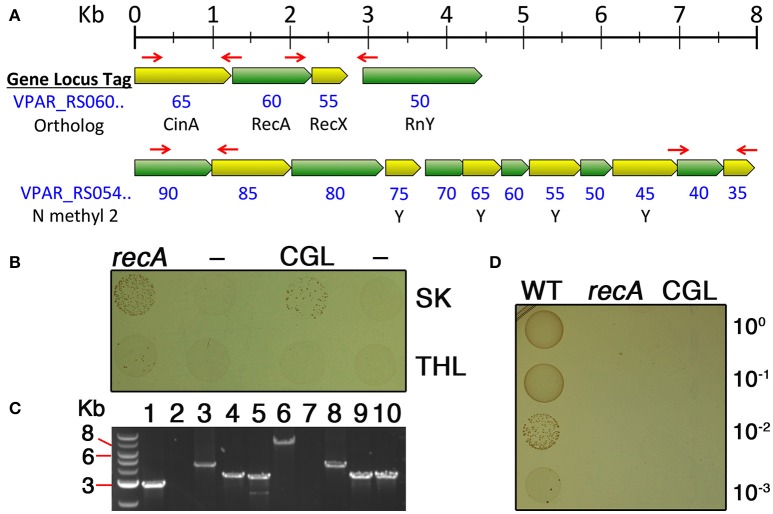
Allelic replacement mutagenesis of recA and a putative competence gene locus. (A) Chromosome maps of regions targeted for allelic exchange mutagenesis. Open reading frames (ORFs) are all drawn to scale. Red arrows indicate the locations of primers used to amplify homologous fragments used for mutagenesis. For both loci, the region between the two primer sets was replaced with a tetM cassette. NCBI gene locus tags are written in blue with the final two digits of the locus tag listed directly below their respective ORFs. For the competence gene locus map, the bottom row (N methyl 2) indicates whether a putative A24 prepilin cleavage/N-terminal methylation motif is present within the ORF. This motif is commonly found among type IV-like prepilins. (B)
V. parvula strain SKV38 was transformed using either SK medium (top row) or THL medium (bottom row) together with PCR products containing allelic exchange mutagenesis constructs for both recA and the competence gene locus (CGL). Ten microliters of the transformation reaction was spotted onto selective medium to isolate transformants. Samples from left to right are: SKV38 + ΔrecA PCR, SKV38 (no DNA), SKV38 + ΔCGL PCR, and SKV38 (no DNA). (C) Transformants from both the ΔrecA and ΔCGL transformations were tested via PCR to confirm the expected genotypes. Samples from left to right are: 1. wild-type gDNA + recA locus external primers (predicted size 2,846 bp); 2. wild-type gDNA + tetM primers (no predicted amplicon); 3. ΔrecA gDNA + recA locus external primers (predicted size 4,176 bp); 4. ΔrecA gDNA + recA locus upstream external primer/tetM reverse primer (predicted size 3,162 bp); 5. ΔrecA gDNA + tetM forward primer/recA locus external downstream primer (predicted size 3,086 bp); 6. wild-type gDNA + CGL external primers (predicted size 7,602 bp); 7. wild-type gDNA + tetM primers (no predicted amplicon); 8. ΔCGL gDNA + CGL external primers (predicted size 3,938 bp); 9. ΔCGL gDNA + CGL upstream external primer/tetM reverse primer (predicted size 2,992 bp); 10. ΔCGL gDNA + tetM forward primer/CGL external downstream primer (predicted size 3,018 bp). (D) Confirmed deletion mutants of recA and the competence gene locus were transformed with gDNA derived from a spontaneous spectinomycin resistant mutant of strain SKV38. Ten microliters of the transformation reaction and three consecutive serial dilutions were spotted onto selective medium to isolate transformants. Samples from left to right are: wild-type (WT), ΔrecA (recA), and ΔCGL (CGL).